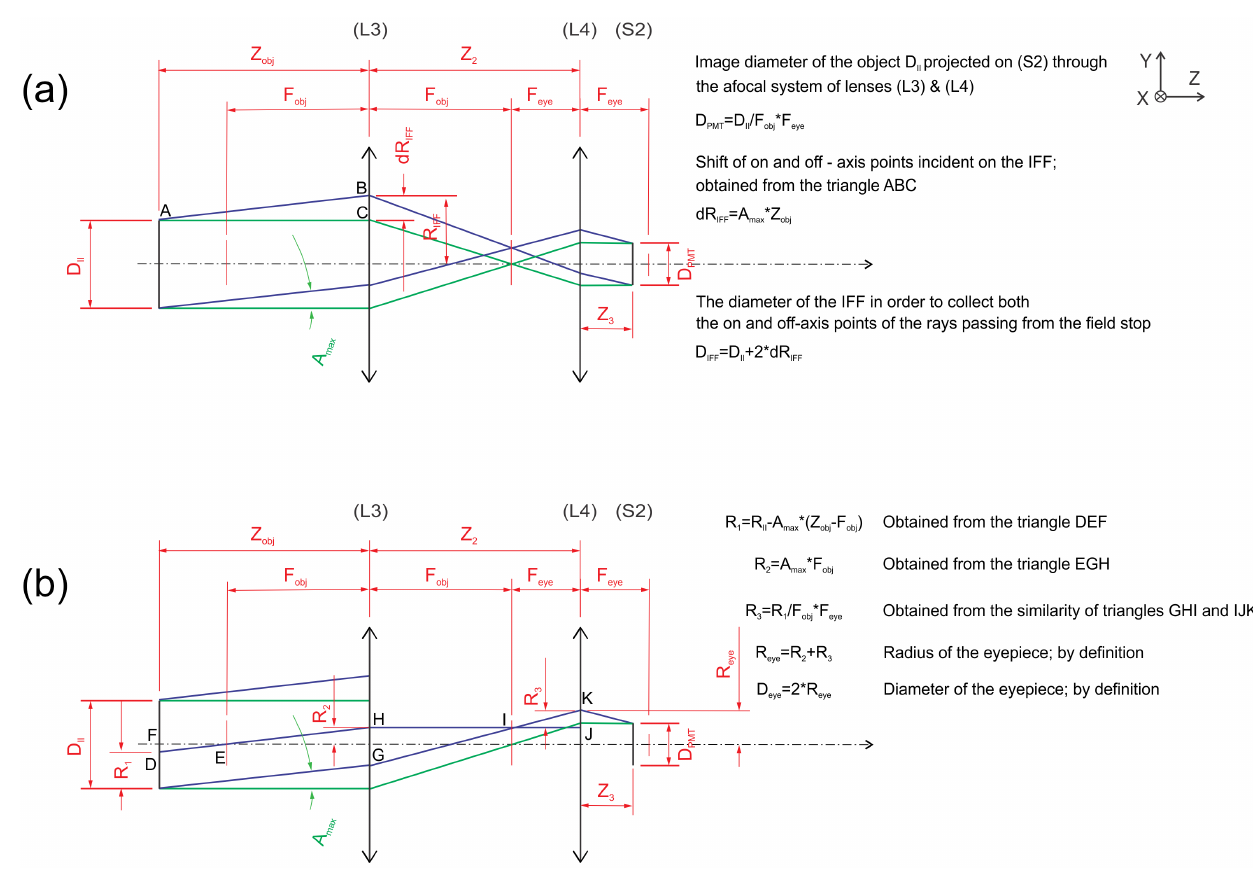
Figure 2. Panels (a) and (b) are essentially the same. However, to help the understanding of geometric calculations, (a) demonstrates the optical path of the on-axis (green line) and off-axis (blue line) points, the first intermediate image (II) of the telescope aperture with diameter D II formed at distance Z obj before the objective lens (L3) and (b) the optical path of the on-axis (green line) and off-axis (blue line) points, of an object (with diameter R 1 ) produced by off-axis points on the intermediate plane. Through the objective lens (L3) with focal length F obj and an eyepiece lens (L4) with focal length F eye the intermediate image is formed again on the surface of the photodetector (S2), at a distance Z 3 behind the eyepiece lens. For reasons of simplicity the IFF is not included in this figure. The focal planes of each lens are denoted with vertical red lines on the principal